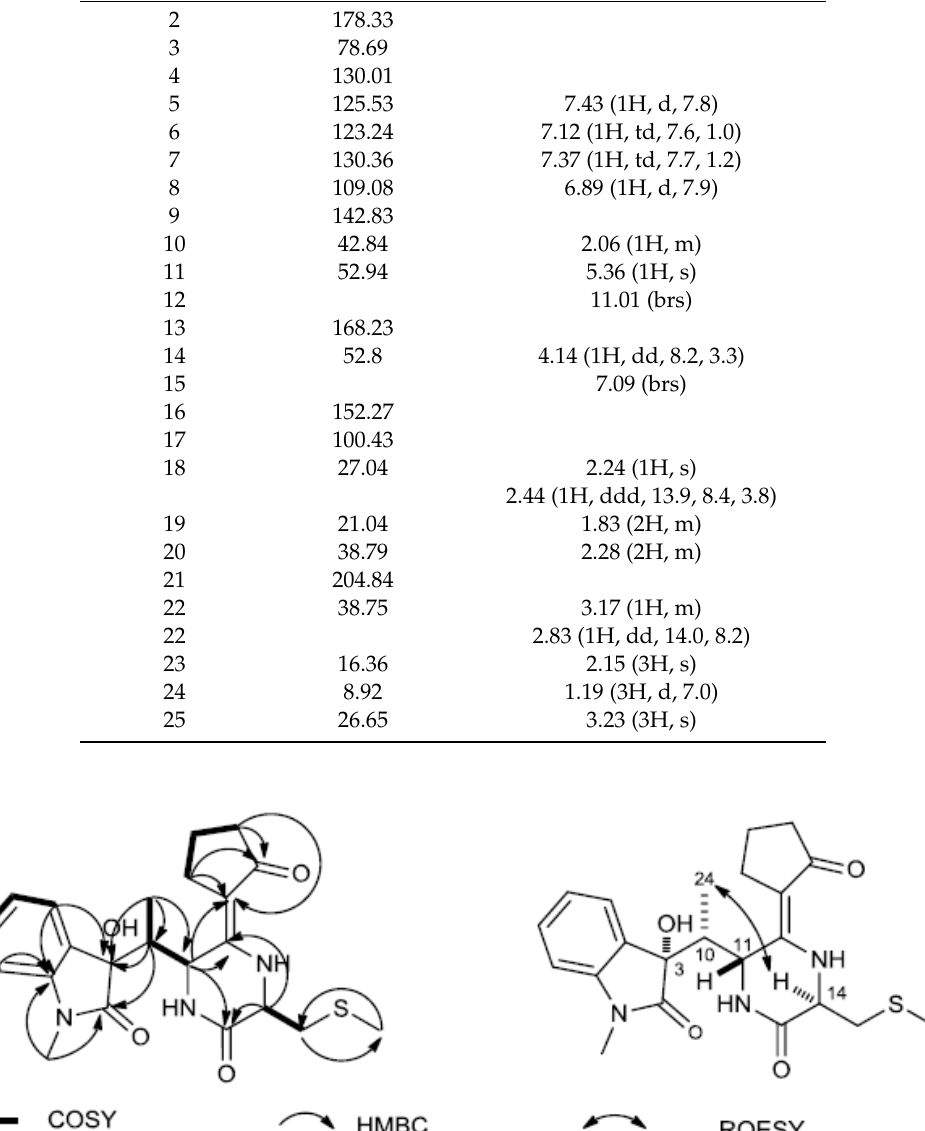
Table 2. 1 H NMR and 13 C NMR data of compound 9 in CDCl 3 .